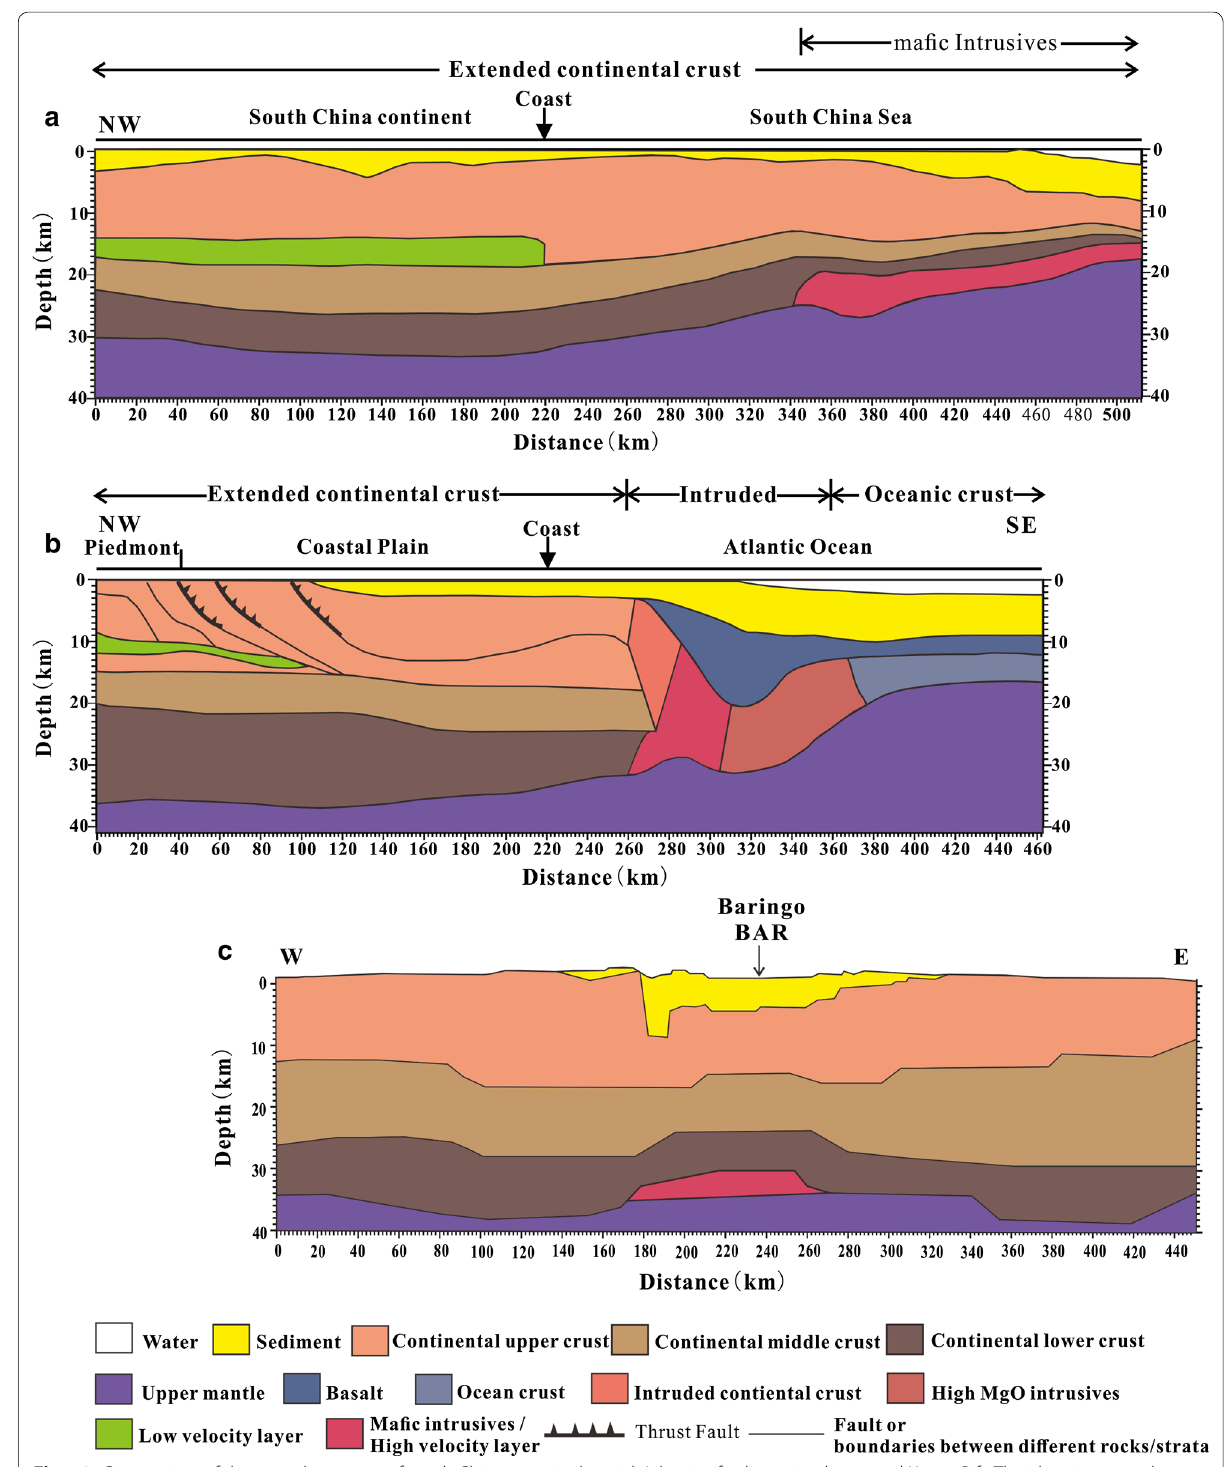
Fig. 18 Comparison of the crustal structure of south China margin, the mid-Atlantic rifted margin, the central Kenya Rift. Their locations are shown in Fig. 16. The crustal structure of the SCS rift ( a ) is inferred by integrating Zhang et al. (2013) and Wan et al. (2017). The crustal structure of the ENAM ( b ) is inferred by integrating our study and Holbrook et al. (1994). The crustal structure of the Kenya Rift ( c ) is inferred from Maguire et al.